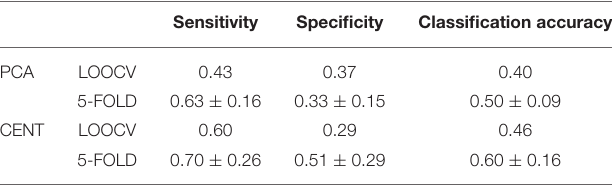
TABLE 2 | Sensitivity, Specificity, and Classification Performance of edge-weights in ML-FCG CorrEnv using the two different ROI representations (PCA and CENTroid) and two cross-validation schemes (Leave-one out cross validation and 5-fold).